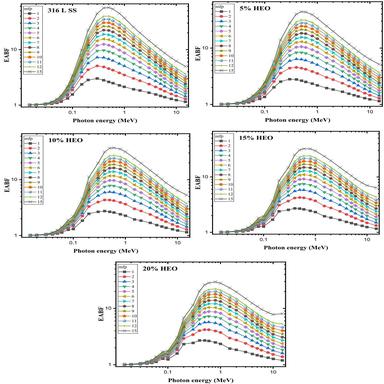
Variation of energy absorption build-up factors (EABF) against photon energy at different penetration depths for the HEO samples.